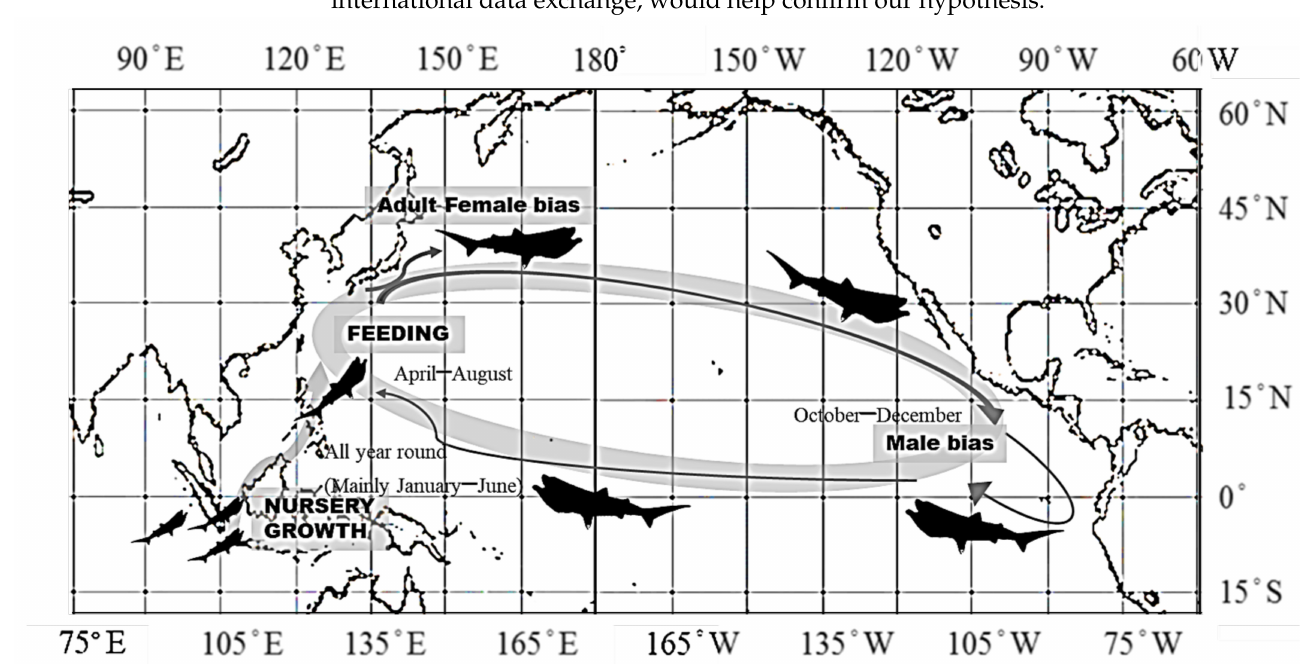
Figure 8. Schematic M. pelagios spatial–temporal distribution model in the Pacific Ocean proposed by this study. Supplementary Materials: The following are available online at https://www.mdpi.com/article/ 10.3390/ani11102947/s1, Table S1: complete megamouth shark records from November 1976